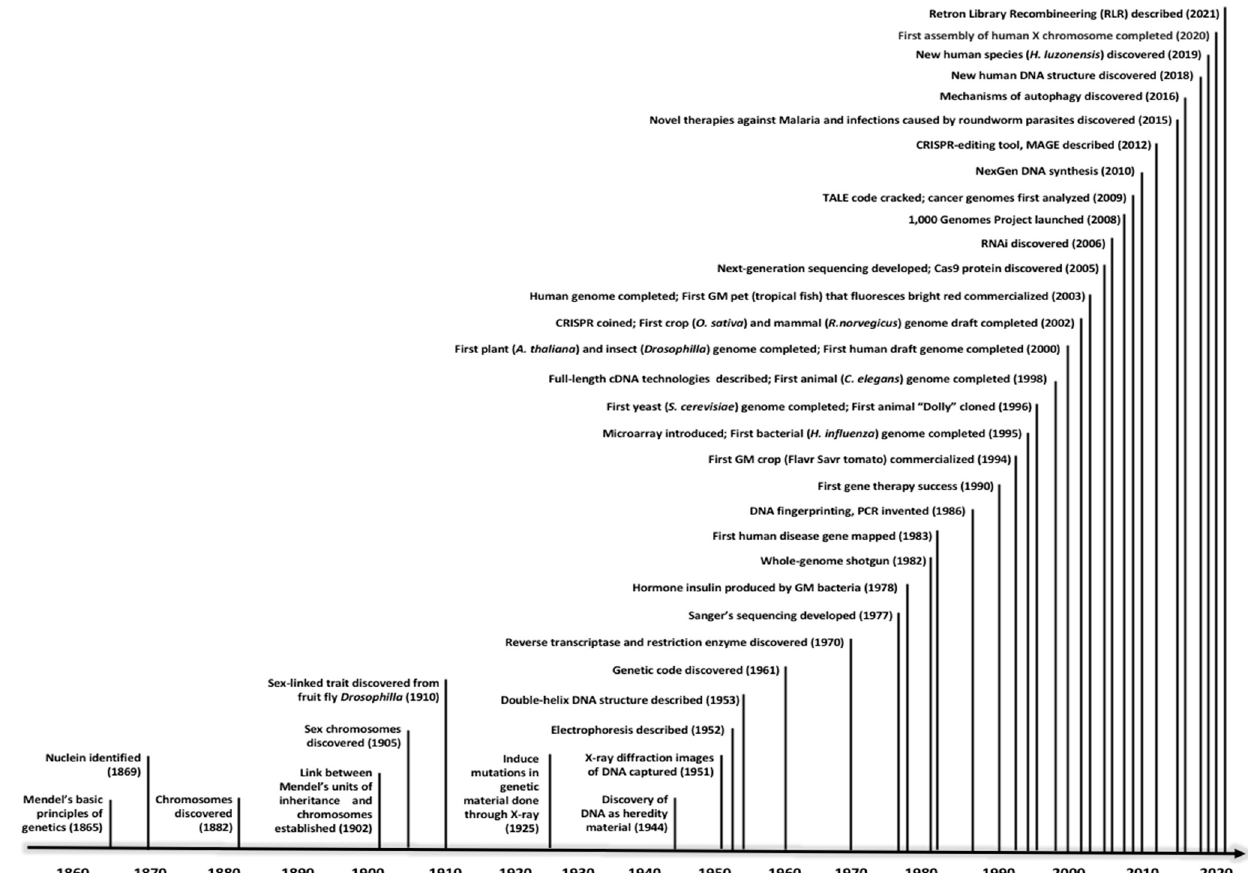
Figure 1. Notable genetic discoveries in the past one and a half centuries.